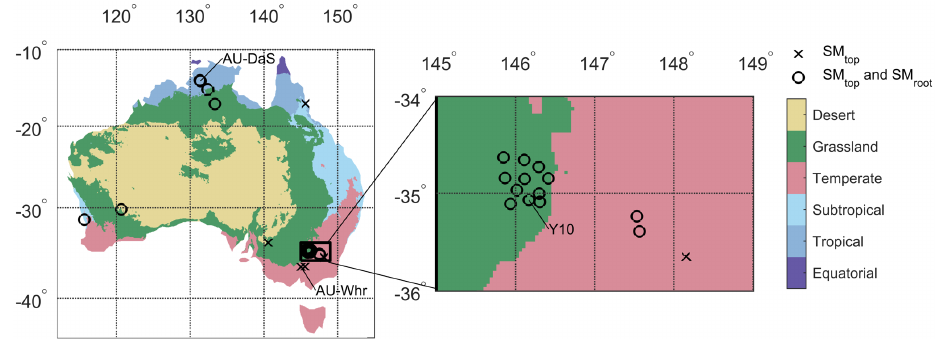
Figure 1. Field-measured soil moisture stations from the OzNet and OzFlux networks plotted against the major Köppen–Geiger climate zones. Stations indicated by crosses provide top-layer soil moisture data individually; sites indicated by a circle also provide root-zone